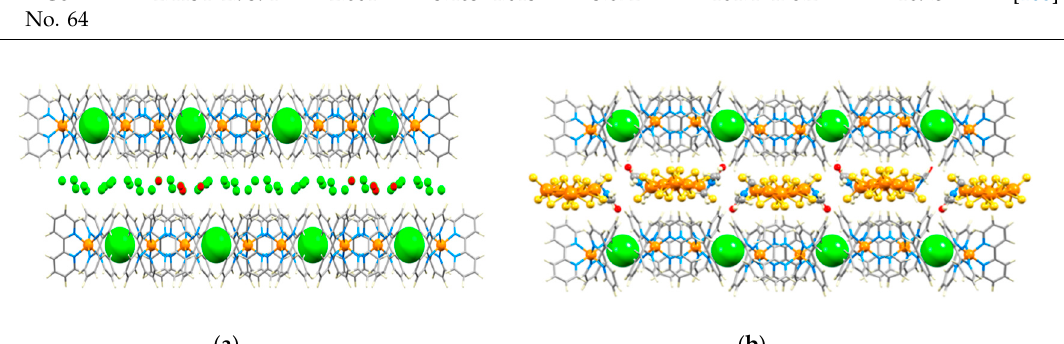
Figure 2. Structure Type 1 with ( a ) chloride ([Ni(bpy) 3 ]Cl 2 ·5.5H 2 O, Refcode EGOVEB) [90], ( b ) bromide ([Fe(bpy) 3 ]Br 2 ·5.5H 2 O, Refcode IFAFUR) [91] and ( c ) iodide ([Li(bpy) 3 ]I·bpy, Refcode REXVOF) [92] ions hosted. Halogen is shown in the space-filling mode, metal atoms in the ball and stick representation and orange, and all the other elements CPK colours. Hydrogen atoms, other than those involved in the interactions with the halide, are omitted.